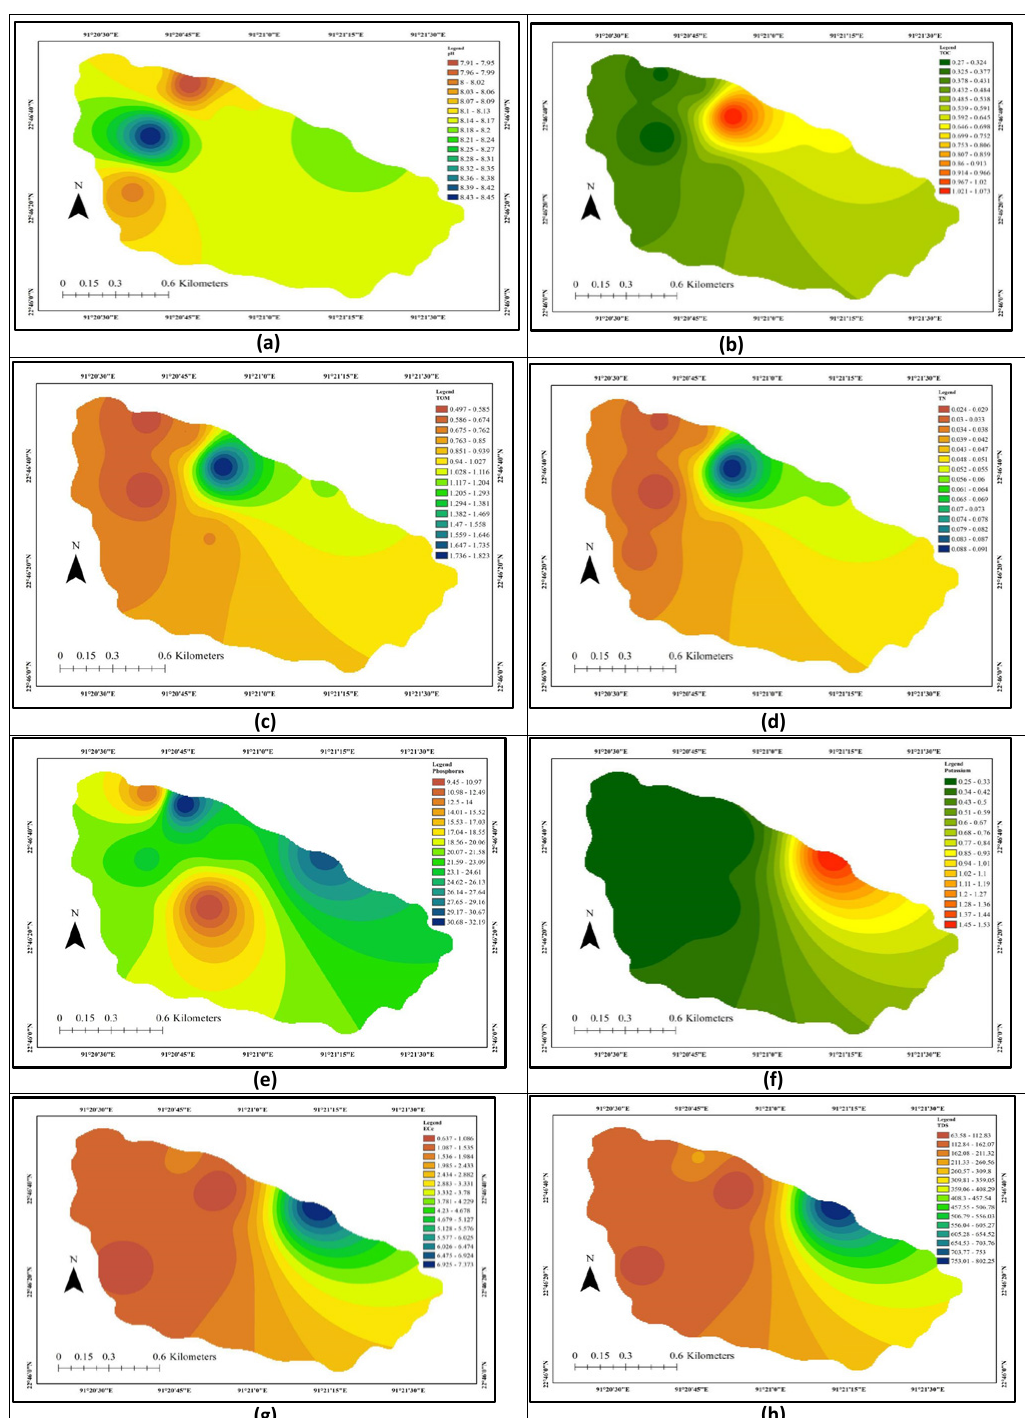
Fig. 3: Distribution of (a) pH, (b) TOC, (c) TOM, (d) TN, (e) Phosphorous, (f) Potassium, (g) EC and (h) TDS